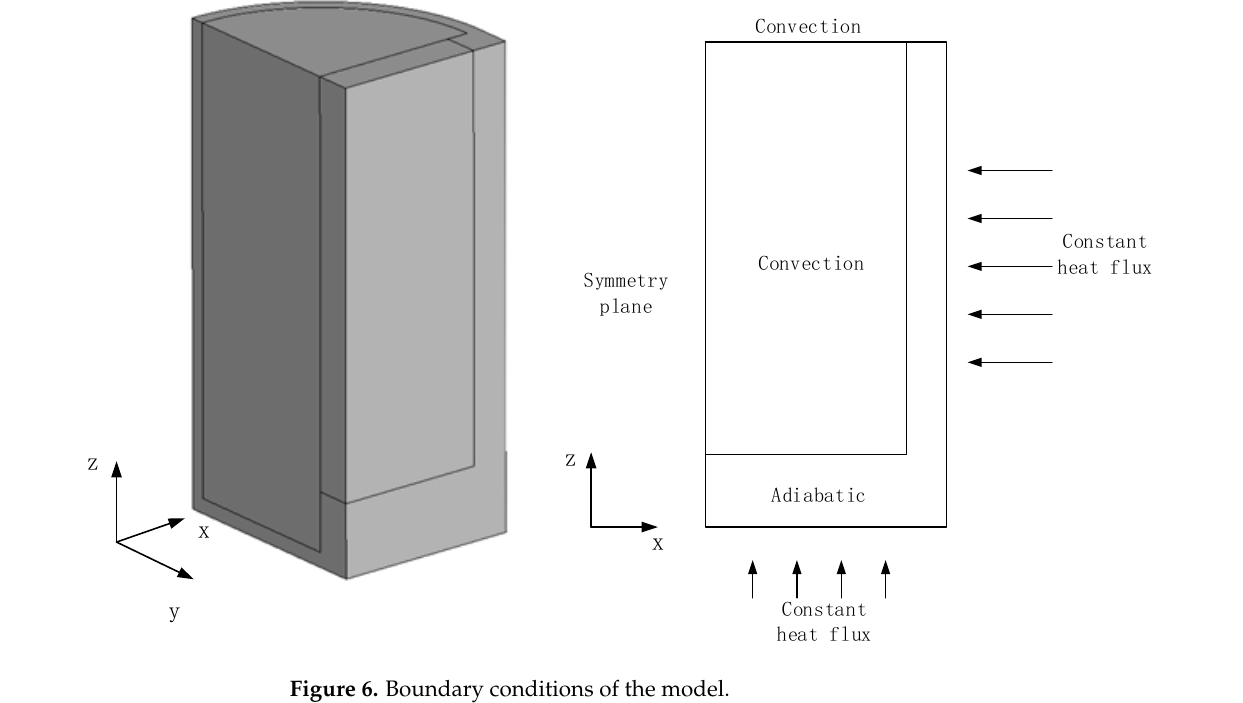
Figure 6. Boundary conditions of the